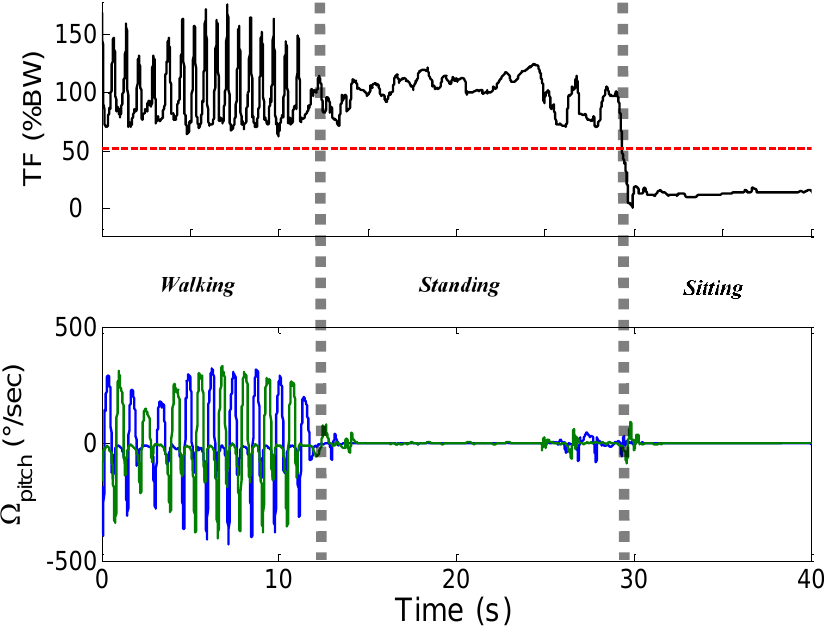
Figure 3. Snapshot of classifier output from one participant (taken ~1 h after the beginning of the recording). Top: plot of TF showing the 50% BW line (dashed red line). Bottom: pitch angular velocity: right foot (blue) and left foot (green). The vertical dashed bars represent different activity periods (walking, standing and sitting).